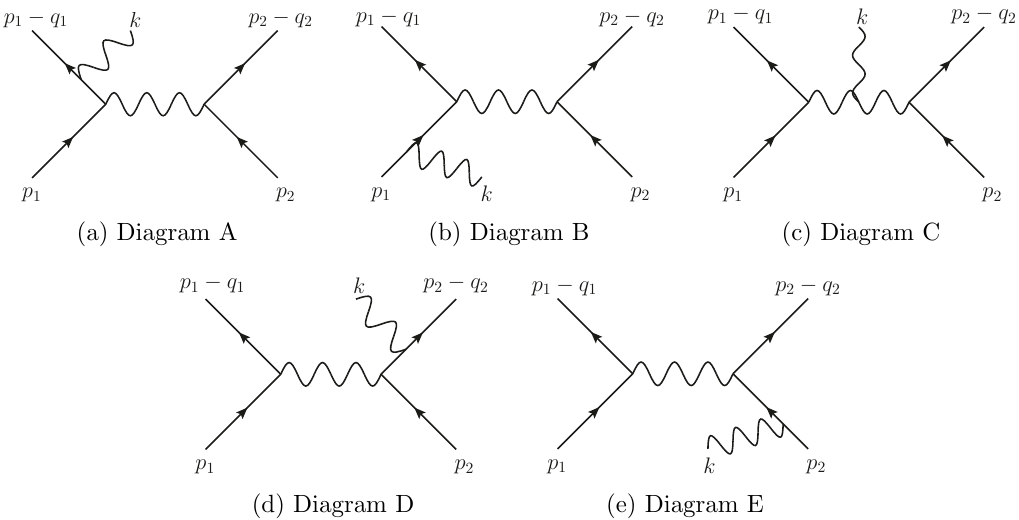
Figure 2. The (cid:12)ve cubic diagrams for inelastic scalar scattering with gluon production in gauge theory, where time runs